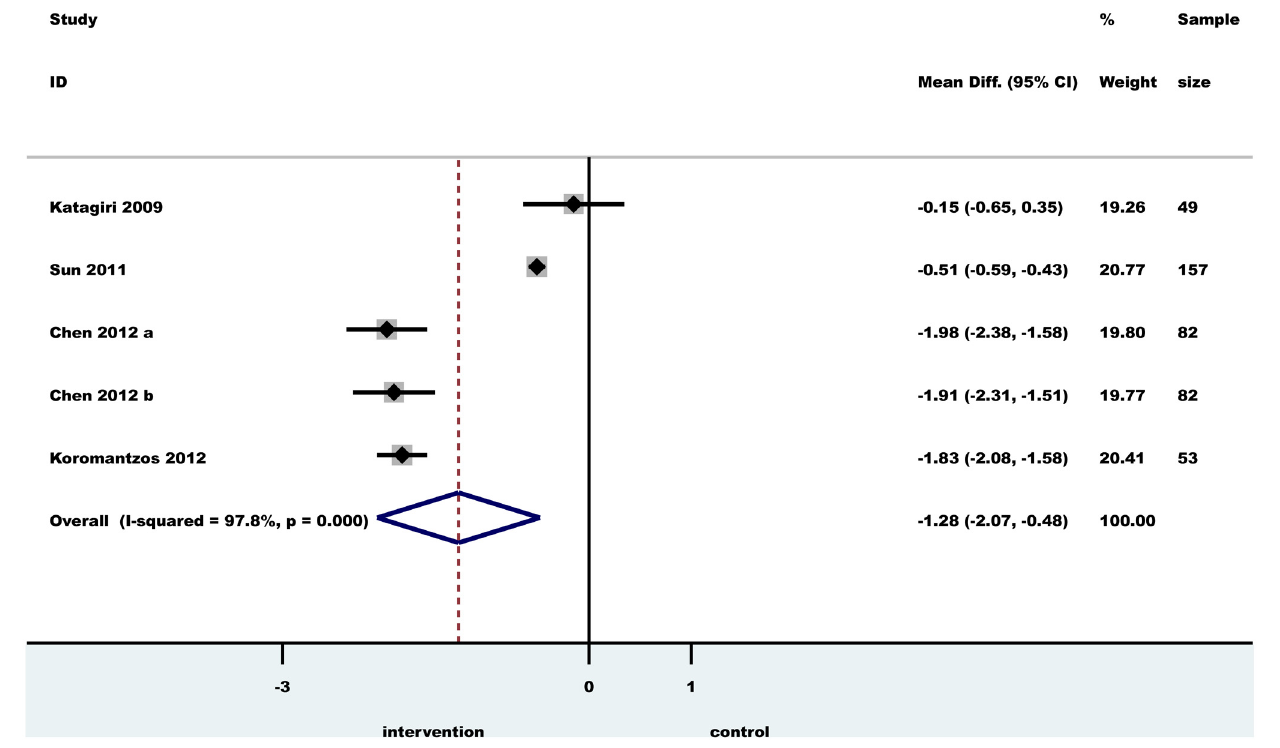
Fig 3. Forest plot of the difference between Δ CRP test and control individuals in randomized controlled trials. Horizontal lines representing 95% CI; diamond represents the overall effect size, random effects models.